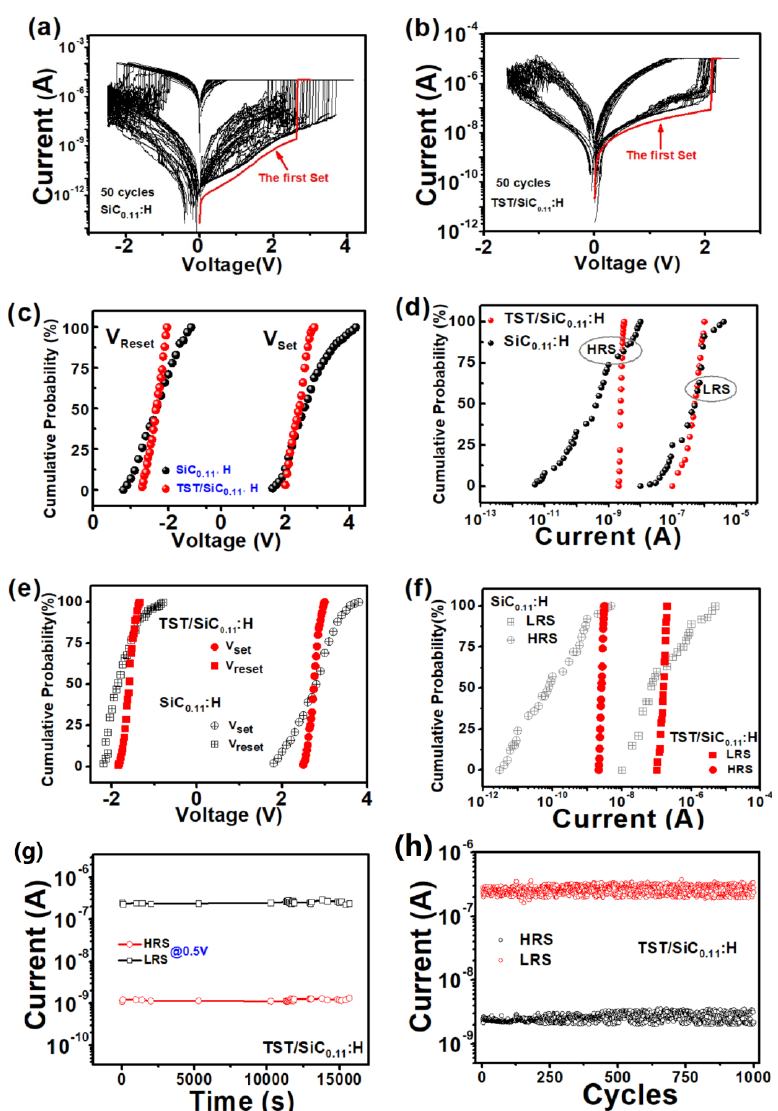
Figure 2. ( a , b ) Resistive switching I – V curves of ASS device and ATSS device during the SET and RESET process after 50 cycles as marked by black lines and the first set is marked by red lines. ( c,d ) Accumulative probability of Vset,Vreset, Ron, and Roff after 50 cycles; ( e , f ) Variation distribution of device-to-device Vset,Vreset, and LRS/HRS values. Data were obtained from 30 ASS and ATSS memristor devices; ( g ) Retention characteristics of the ATSS memristor device at 80 °C; ( h ) The endurance characteristic of the ATSS memristor. In order to understand the correlation between resistive switching and the atomic configurations of a-SiC 0.11 H films, the corresponding Fourier transform infrared (FTIR) spectroscopy and electron spin resonance (ESR) spectra were analyzed, as shown in